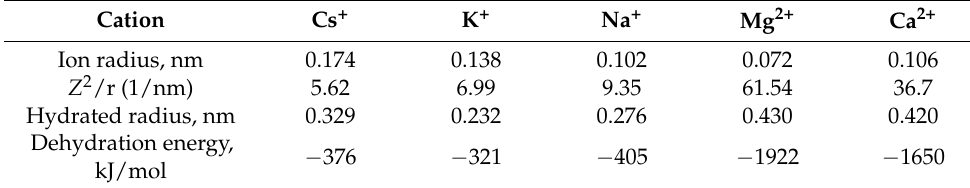
Table 3. Effective and hydrated cation radii and dehydration e6nergy [36].